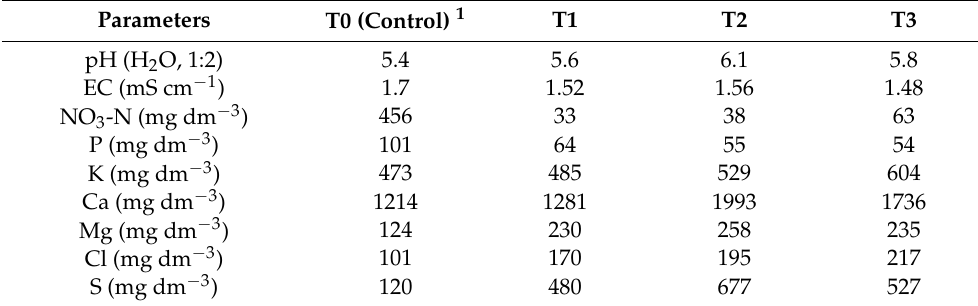
Table 6. Chemical properties of tested growing media: T0 (control—100% peat substrate); T1 (25% compost, 30% sphagnum peat, 15% fen peat, 20% pine bark, 10% wood fiber); T2 (30% compost, 20% sphagnum peat, 30% fen peat, 10% pine bark, 10% wood fiber); and T3 (30% compost, 0%